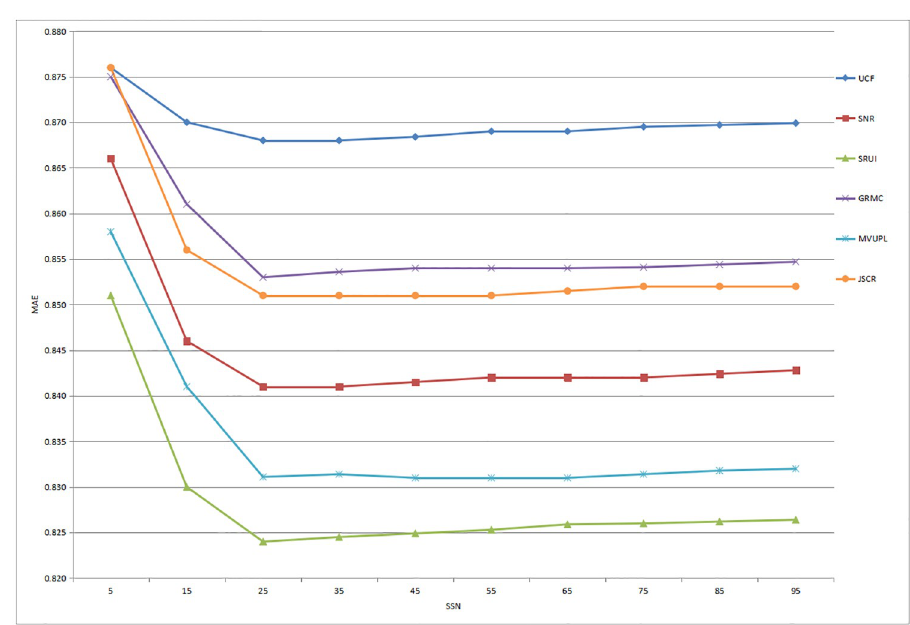
Fig 3. Prediction accuracy of all the comparison methods for different numbers of social similar neighbors based on the Douban dataset (MAE).